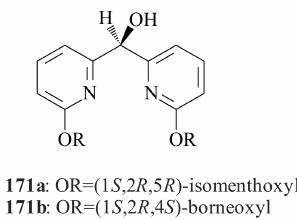
Figure 39. α -Bipyridinyl alcohols with alkoxy groups at the α ’-positions of the pyridine